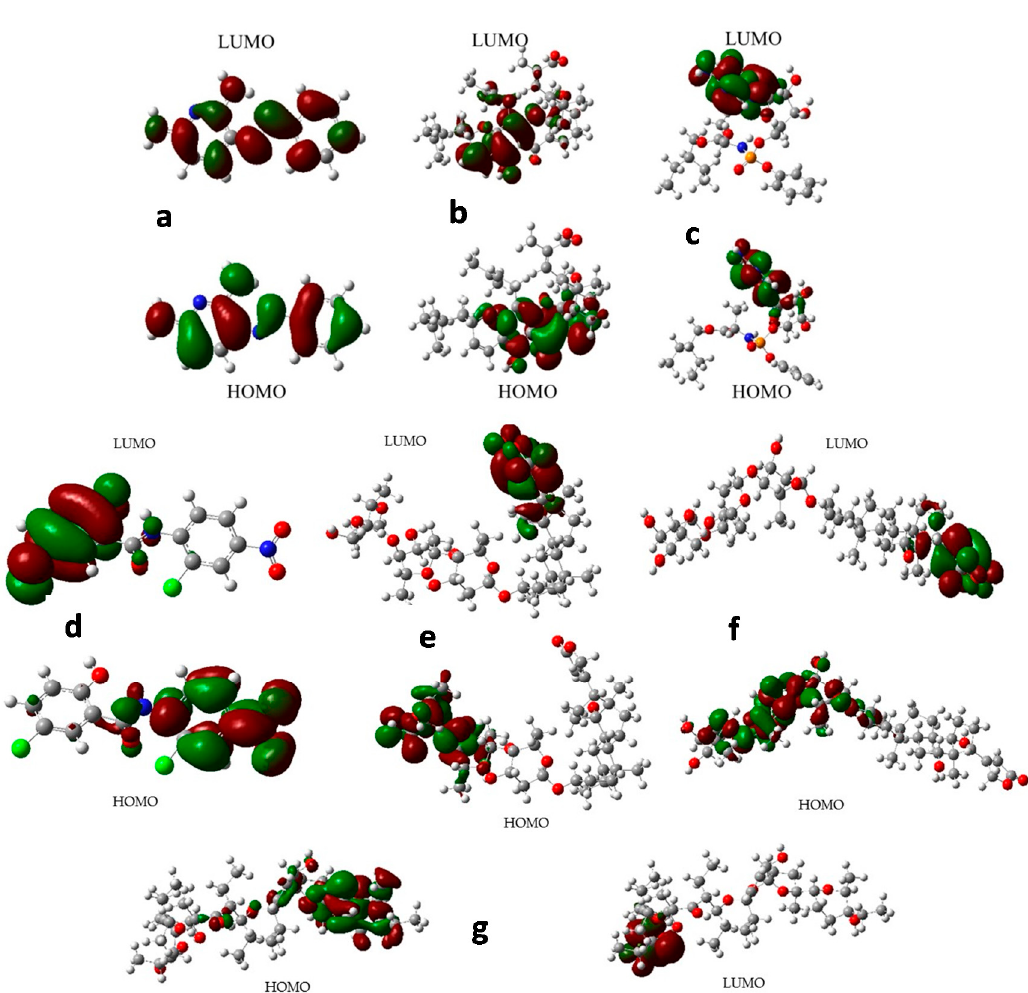
Figure 14. Frontier orbital for ( a ) phenazopyridine; ( b ) dihydrogambomic acid; ( c ) remdisivir; ( d ) Niclosamide; ( e ) Digitoxin; ( f ) digoxin; ( g ) salinomycin. HOMO: highest occupied molecular orbital. LUMO: lowest unoccupied molecular orbital.